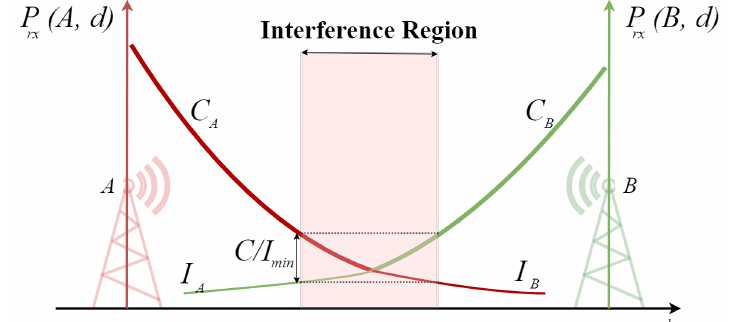
Figure 6. Illustration of the received signal level decay with distance for two neighboring cells: the corresponding interference region is